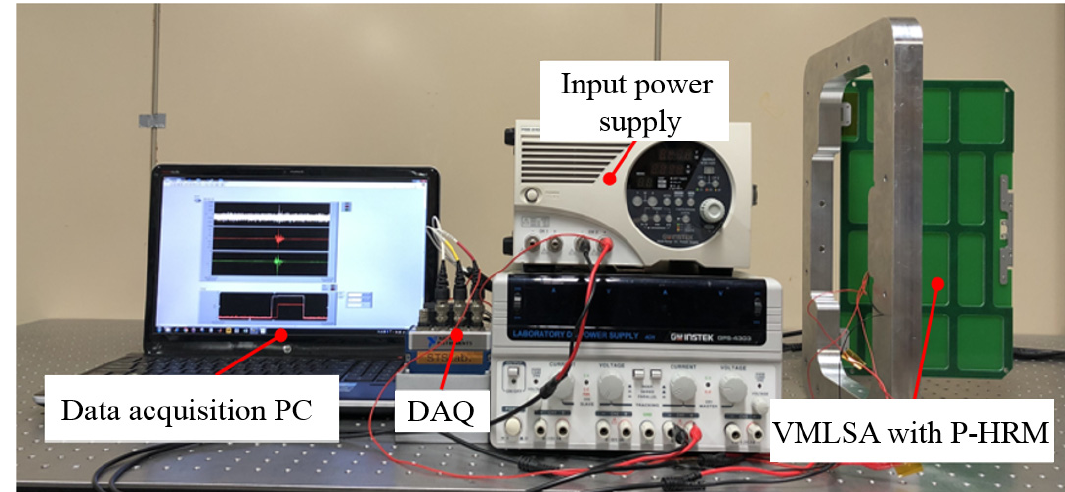
Figure 10. The solar panel deployment test setup.